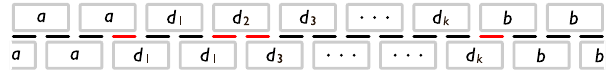
FIG. 16. A generic configuration of an odd row of boundaries denoted as ð ad 1 d 2 d 3 ; … ; d k b Þ . Costly boundaries (DWs) are wall drawn in red. Costless boundaries are drawn in black.